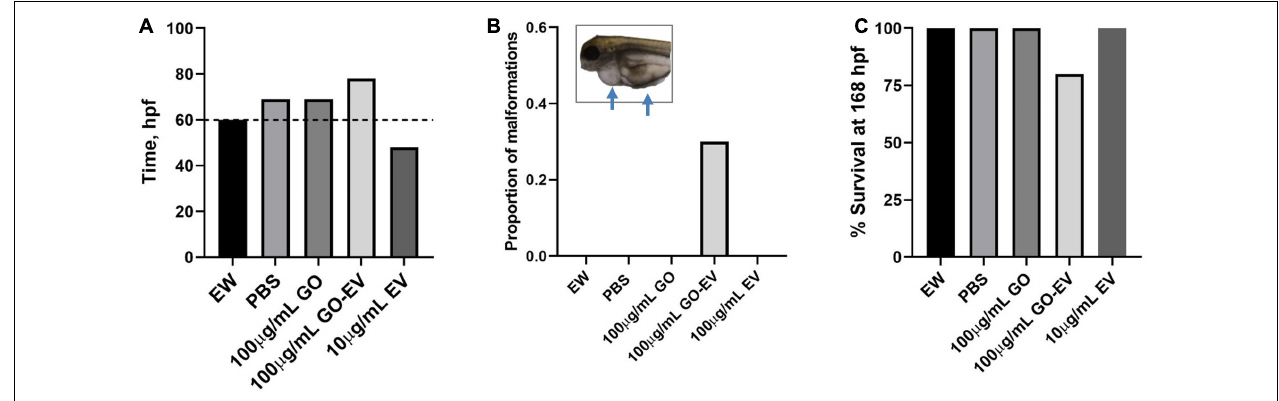
FIGURE 7 | Developmental toxicity of GO-EV in zebrafish. At 24 h post-fertilization (hpf) zebrafish ( n = 10) were incubated in embryo water (EW) alone or EW containing 100 µ g/mL GO, 100 µ g/mL GO-EV or 10 µ g/mL EV every 24 h for a total of 168 h. (A) The time at which 70% of the zebrafish hatched following treatment with GO-based biomaterials was recorded from 45 to 85 hpf. (B) The zebrafish treated with GO-based biomaterials were monitored for the development of any malformations and the proportion of malformations present in each treatment group was calculated. Pericardial and/or yolk sac edema was observed in some zebrafish treated with GO-EV. (C) The survival of the zebrafish treated with GO-based biomaterials was recorded at 168